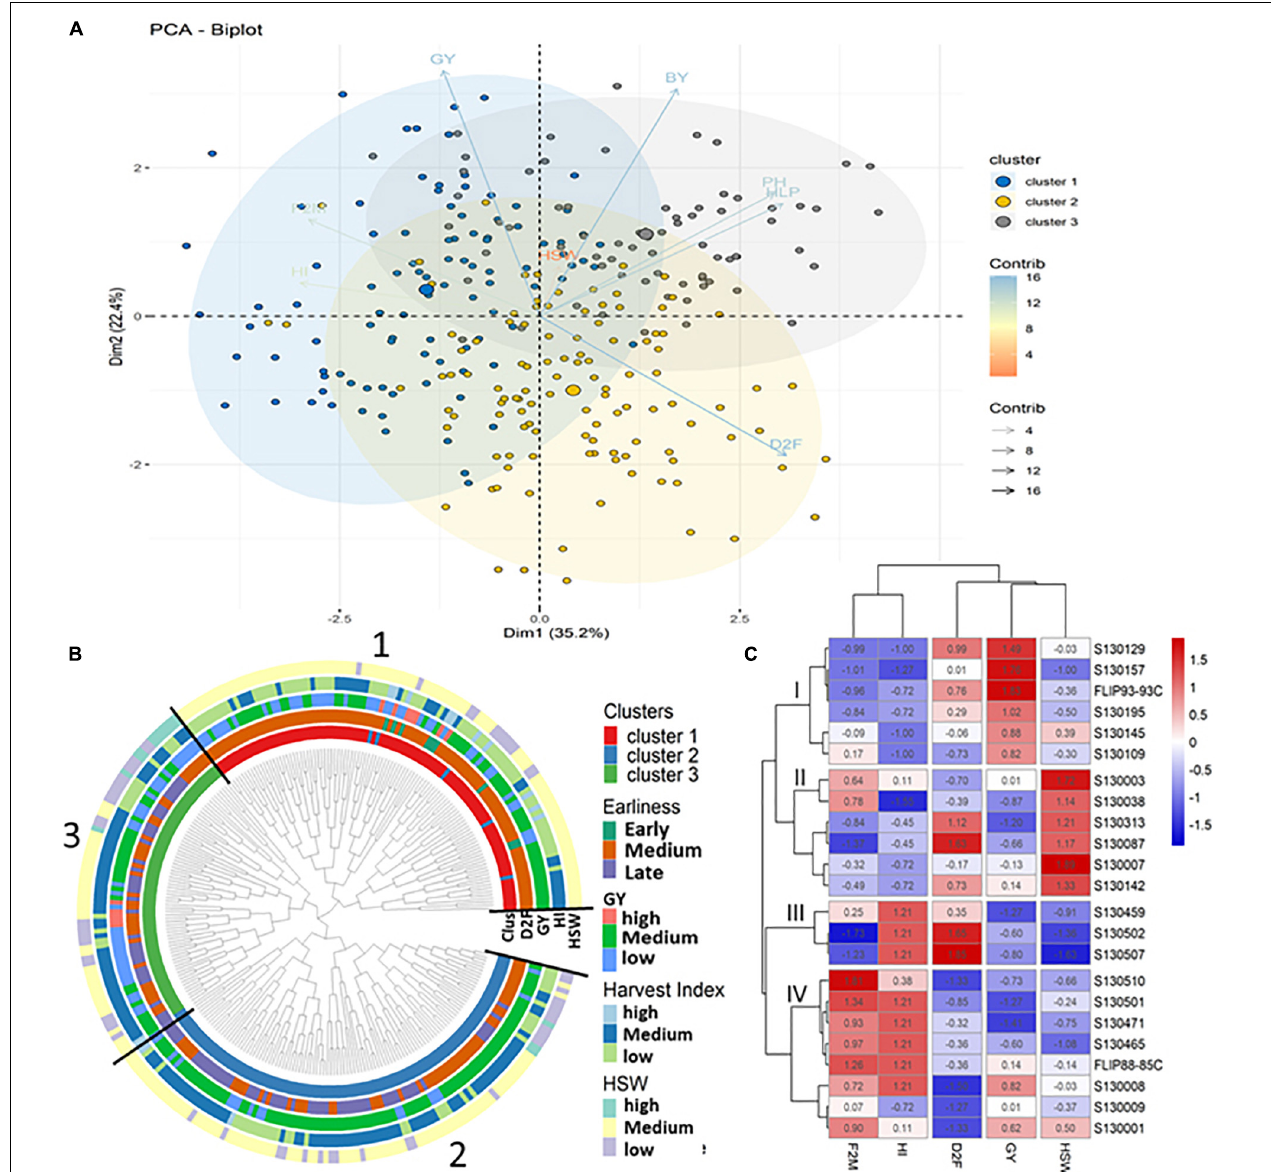
FIGURE 2 | (A) Biplot of the first two dimensions of the principal component analysis (PCA). (B) Dendrogram showing the list of genotypes grouped in each cluster based on agronomic performances. (C) Heatmap and hierarchical clustering of 23 genotypes selected based on their agronomic performances.